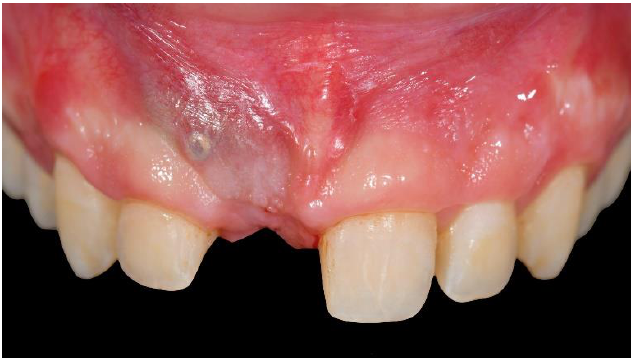
Figure 7. Intraoral view 4 months after uncomplicated healing.